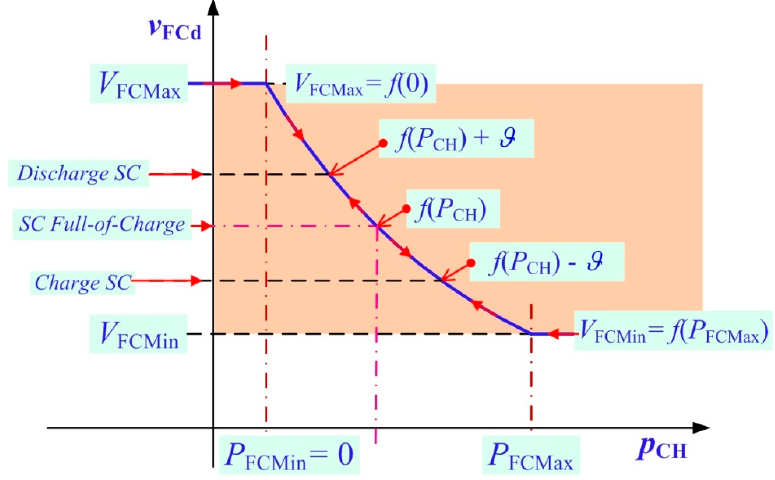
Figure 11. Algorithm of the desired FC voltage generation.